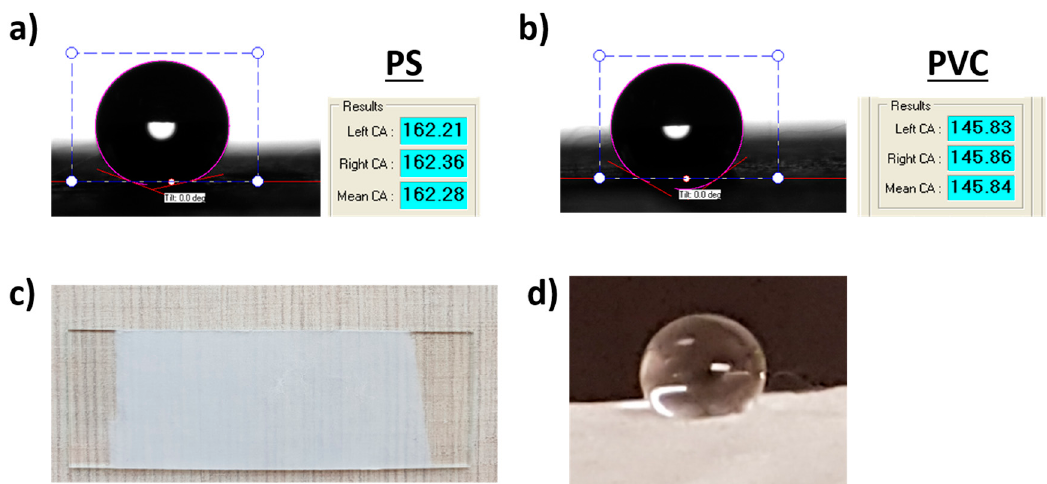
Figure 2. Optical image of the water contact angle (WCA) value for PS ( a ) and PVC ( b ) samples; ( c ) Aspect of the electrospun fibers with a characteristic white coloration deposited onto a standard microscope glass slide; ( d ) A picture of the water drop onto the electrospun fibers.